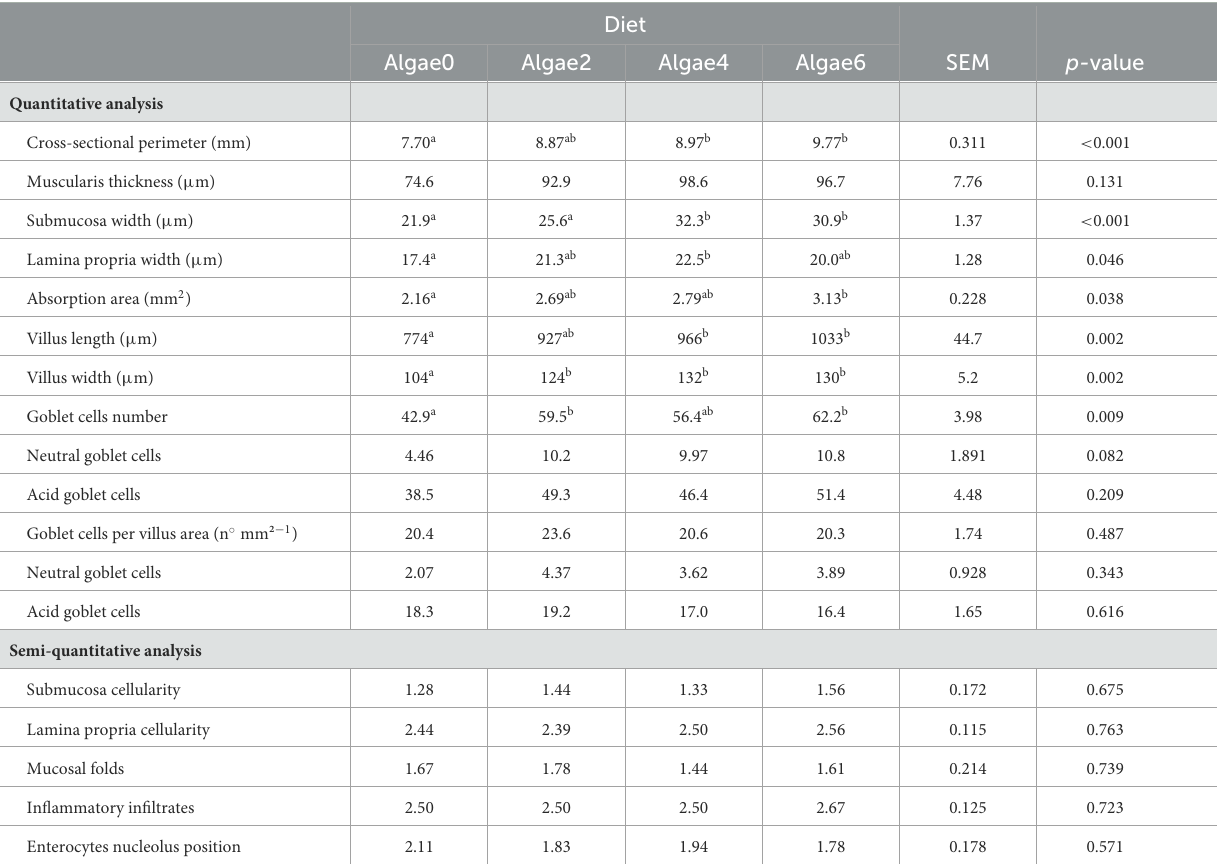
TABLE 5 Anterior intestine morphology of European seabass juveniles fed the experimental diets. Diet Algae0 Algae2 Algae4 Algae6 SEM p- value